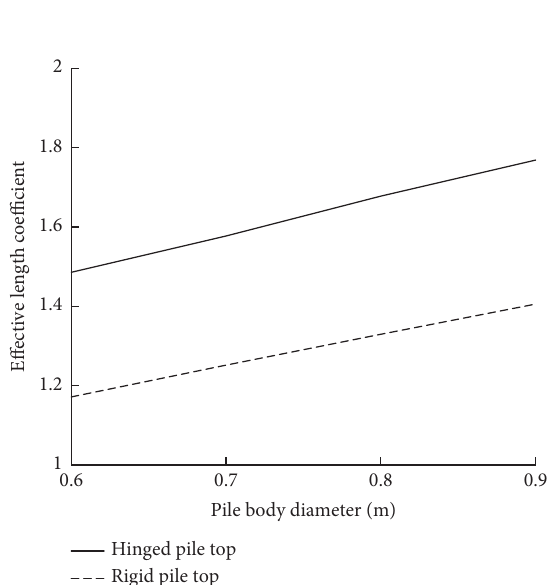
Figure 8: Load factor-pile body diameter.